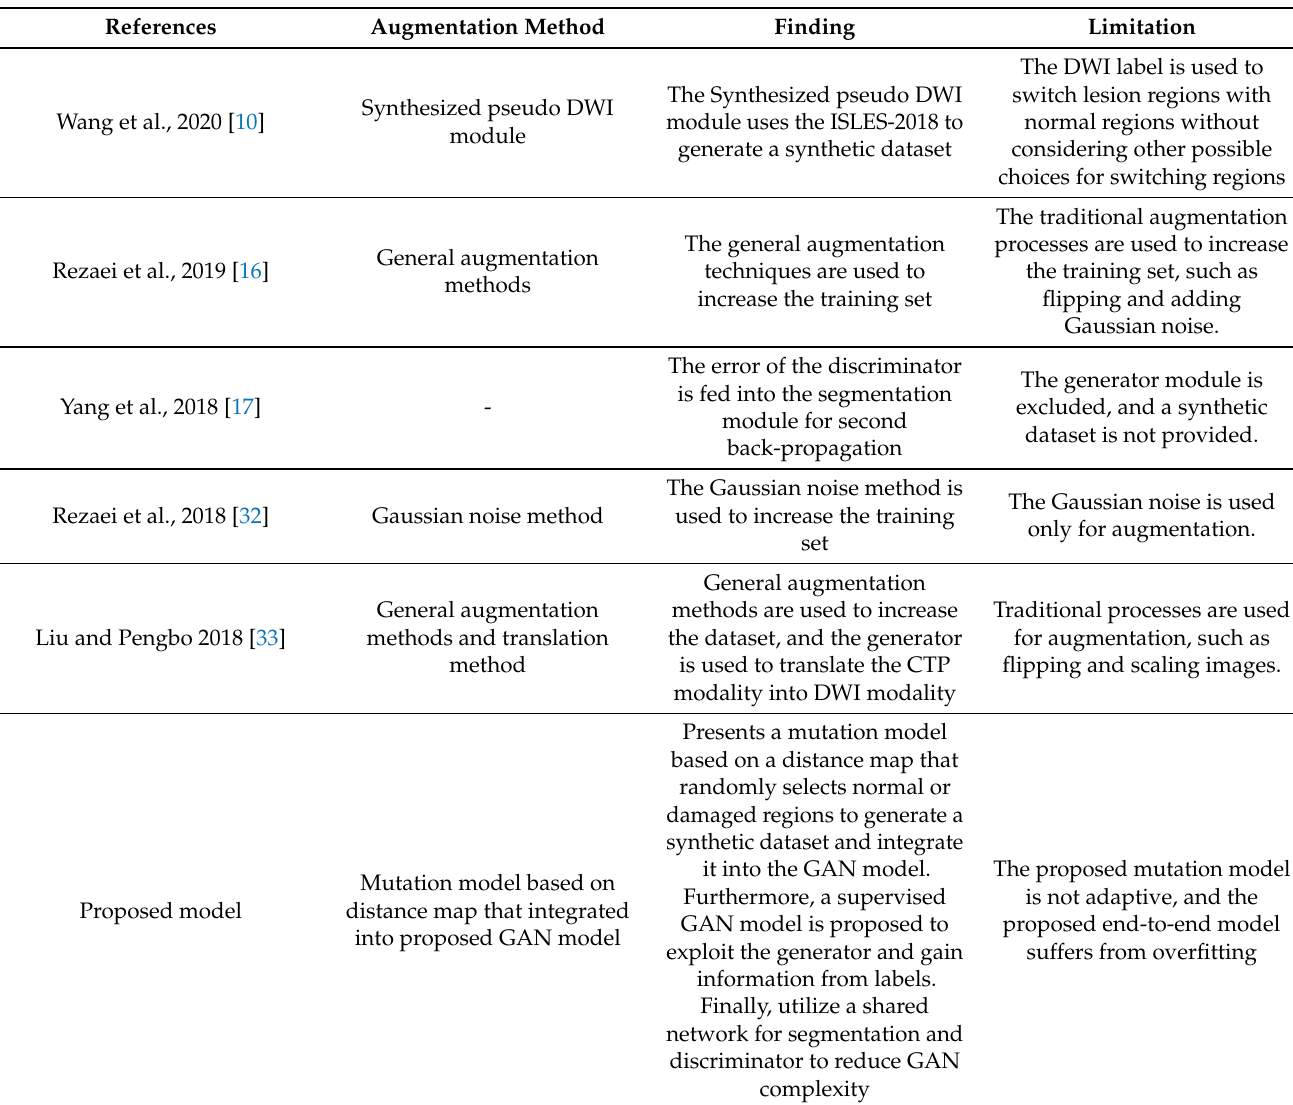
Table 2. Summary of the existing GAN and proposed models that use the ISLES-2018 dataset for